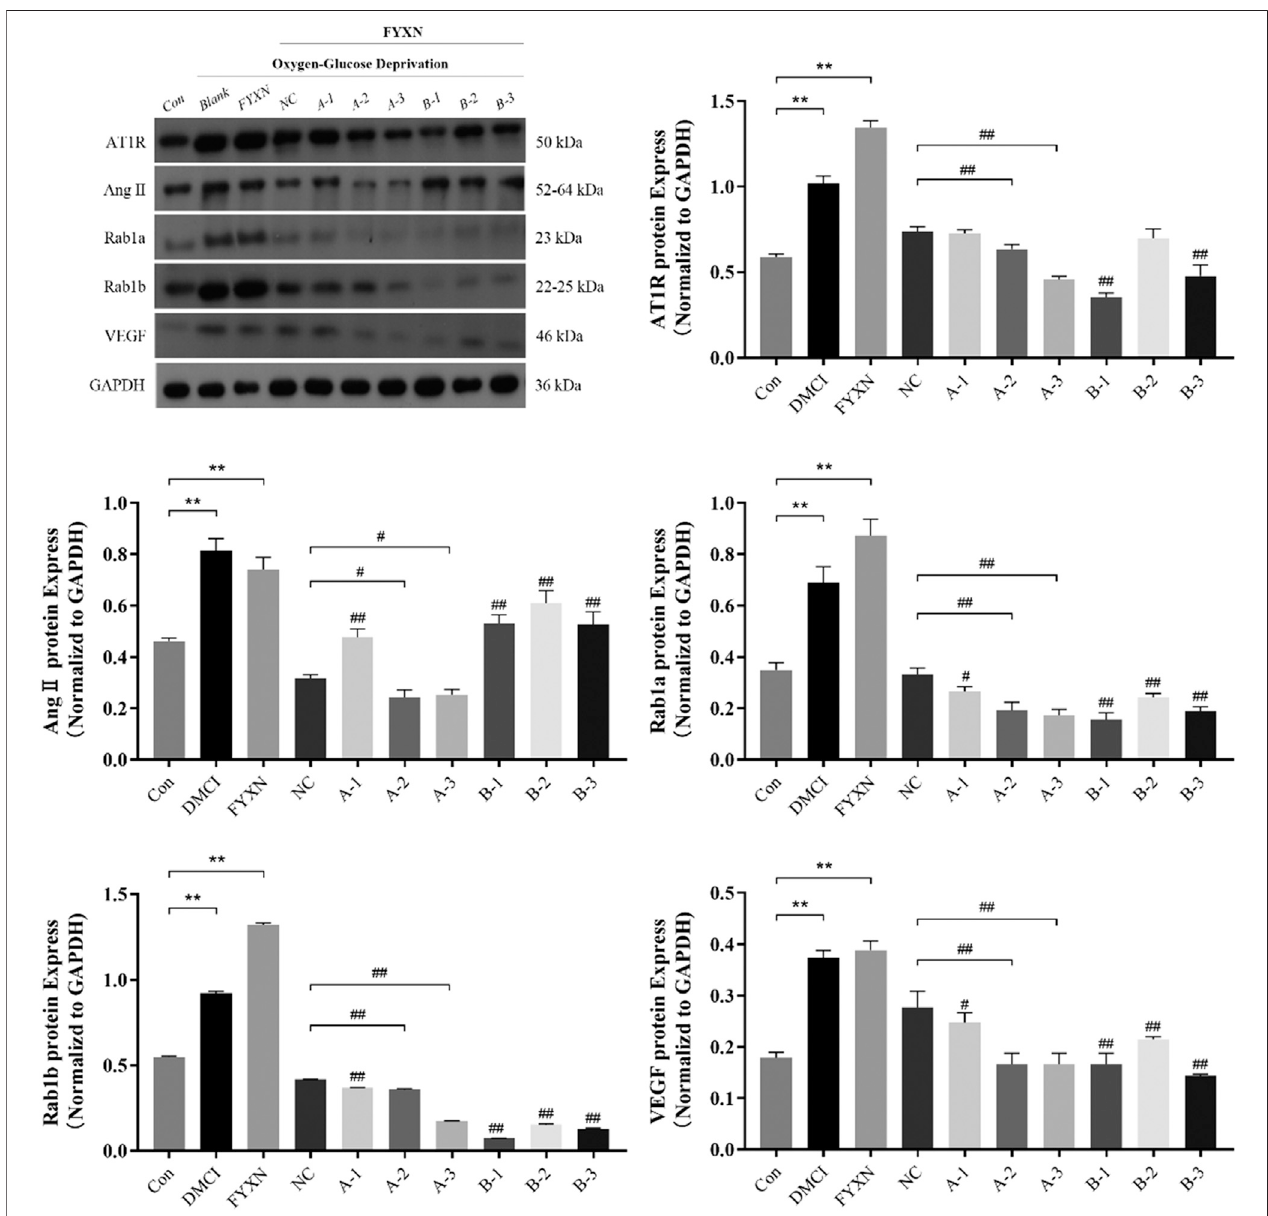
FIGURE12| Theexpressionlevelsofangiogenesis-associatedproteins(AT1R,AngII,Rab1a,Rab1b,VEGF)afterinterferencewithRab1aandRab1b invitro .The Rab1a siRNA sequences of A1, A2 and A3, and the Rab1b siRNA sequences of B1, B2 and B3. * p < 0.05, ** p < 0.01, compared with control group; # p < 0.05, ## p < 0.01, compared with NC